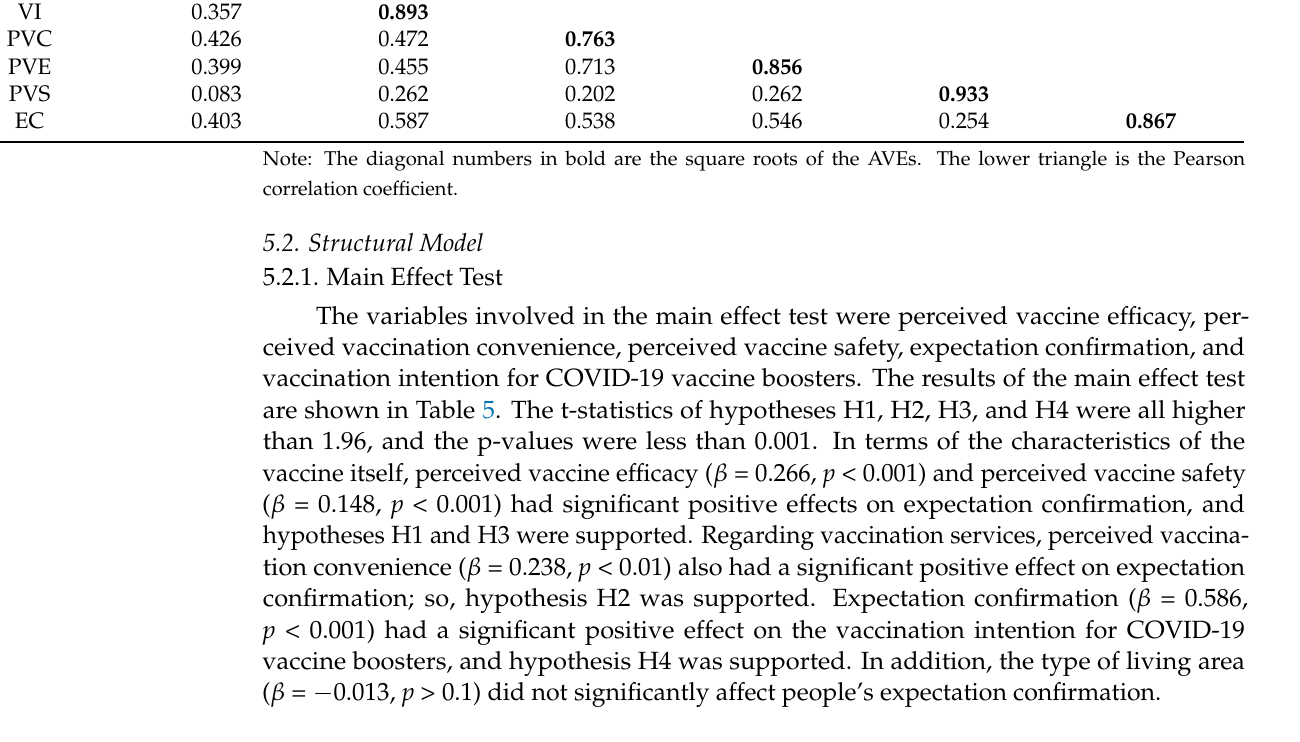
Table 5. Main effect test results of the research